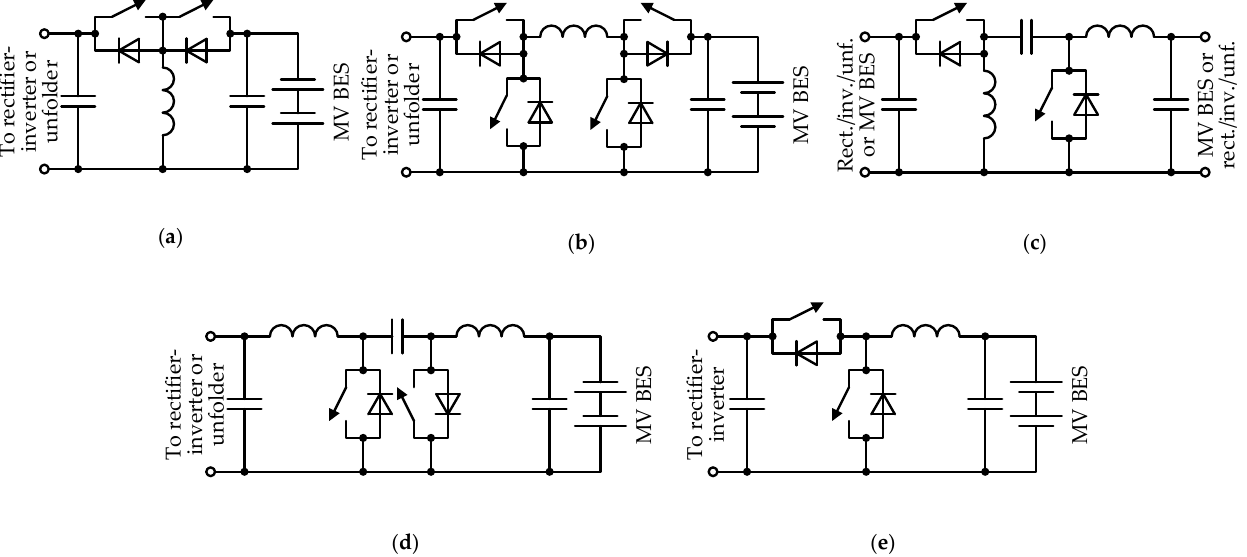
Figure 18. DC-DC stage of BES interface converters with two stages: ( a ) inverting bidirectional buck-boost, ( b ) bidirectional non-inverting buck-boost, ( c ) bidirectional zeta-SEPIC, ( d ) bidirectional Č uk, ( e ) synchronous buck.